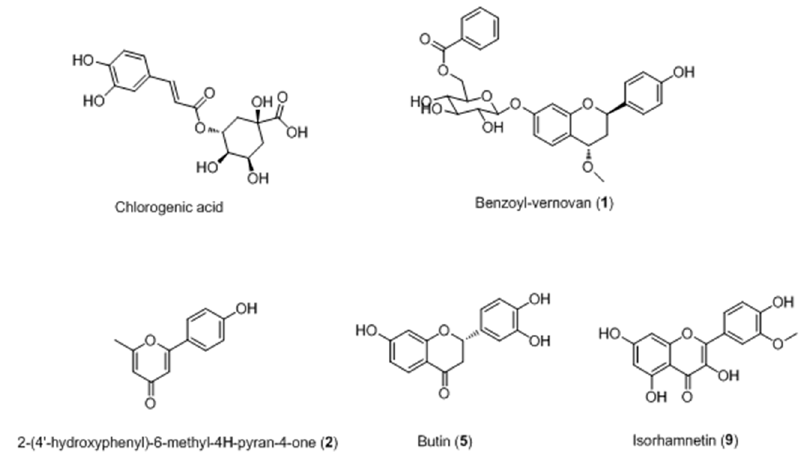
Figure 3. Structures of compounds isolated from Vernonia anthelmintica [47,48].